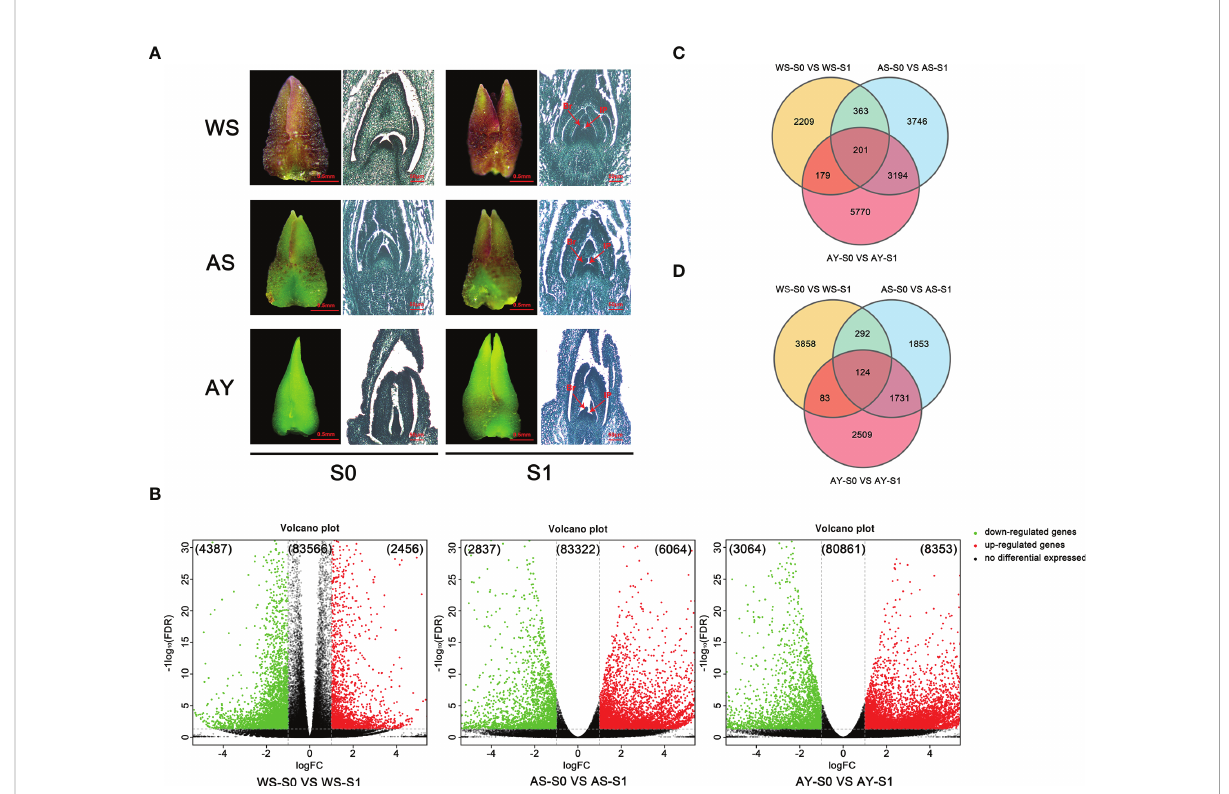
FIGURE 3 Comparative analysis of DEGs during the fl oral transition process in OF and CF habits. (A) Samples for transcriptome sequencing analysis. WS: buds blooming in winter from ‘ Sijigui ’ ; AS: buds blooming in autumn from ‘ Sijigui ’ ; AY: buds blooming in autumn from ‘ Yanhonggui ’ . S0: undifferentiation buds; S1: differentiation buds (mix of in fl orescence primordium differentiation stage and small fl oret primordium differentiation stage). Br: bract; Ip: in fl orescence; FP: fl oret primordium. (B) The expression trends of DEGs in the three comparisons. Green circles: downregulated genes; red circles: upregulated genes; black circles: non-differentially expressed genes. (C) Venn diagram of the number of upregulated genes among the three comparisons. (D) Venn diagram of the number of downregulated genes among the three